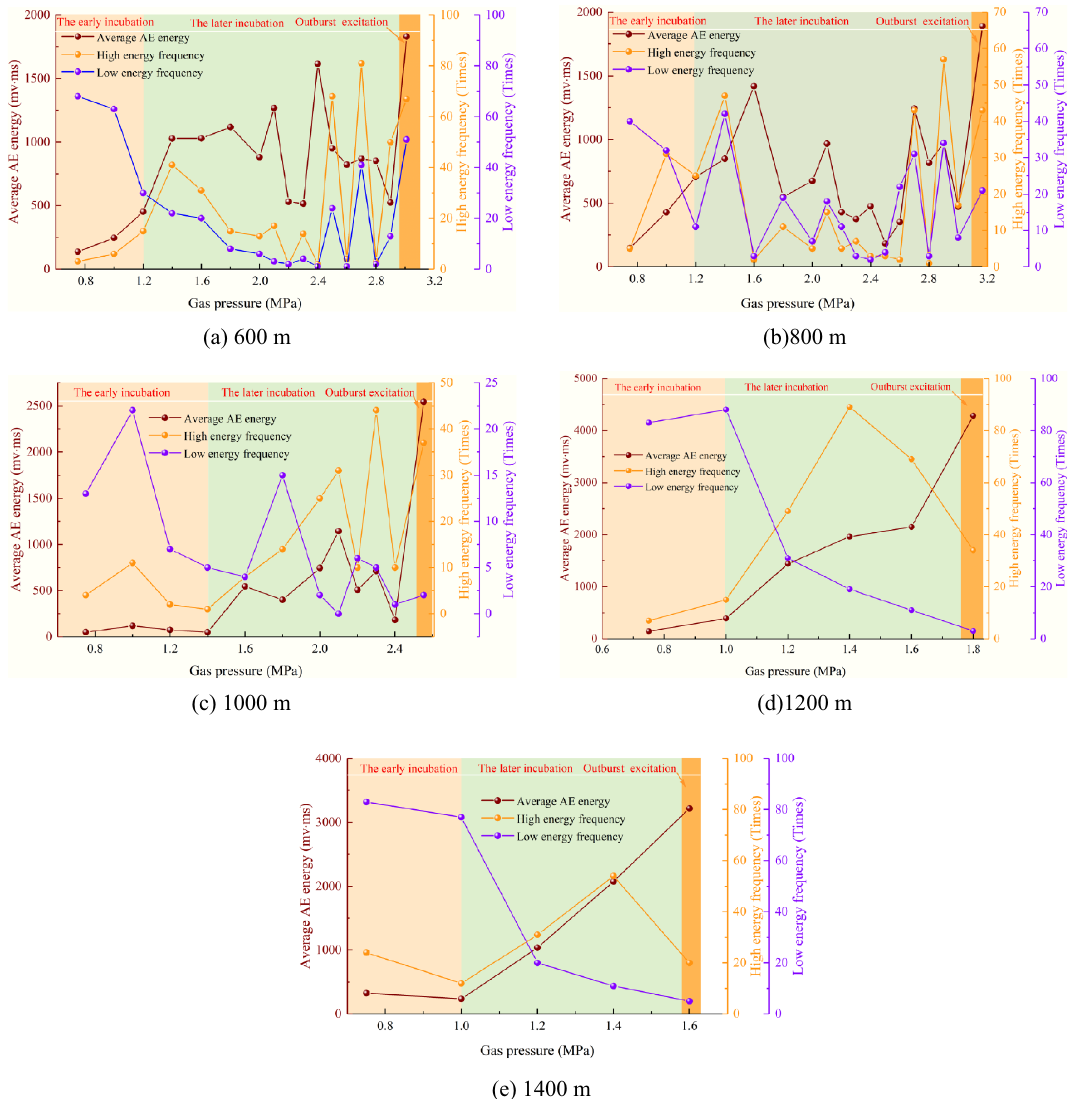
Figure 12. Curve of relationship among gas pressure, average AE energy and energy